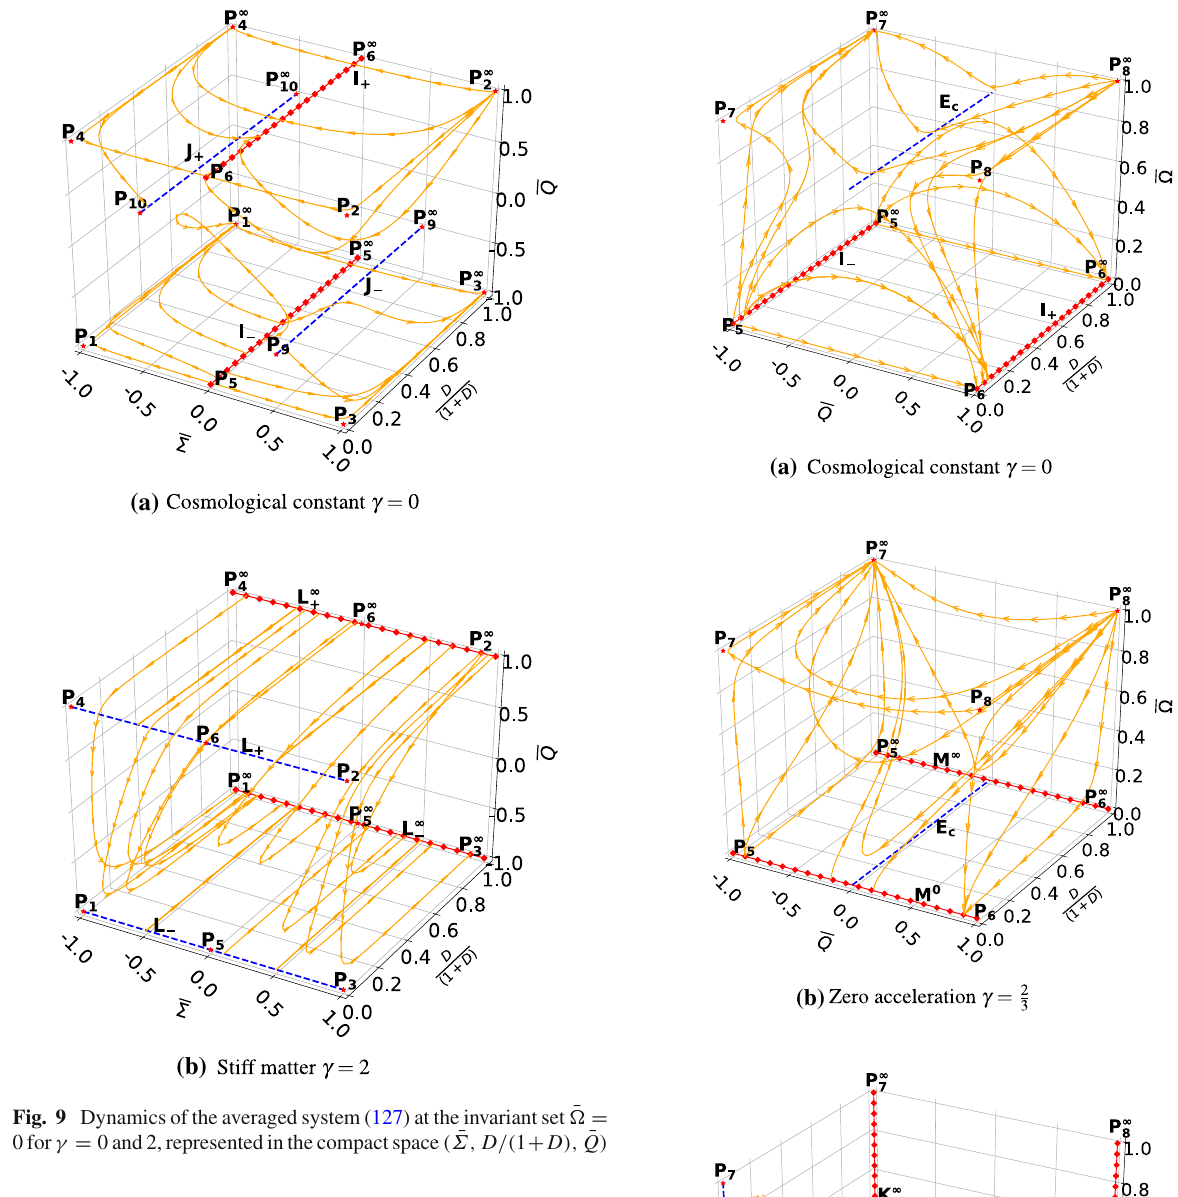
¯ (cid:8) = 0 corresponding to vacuum ¯ Σ, D /( 1 +